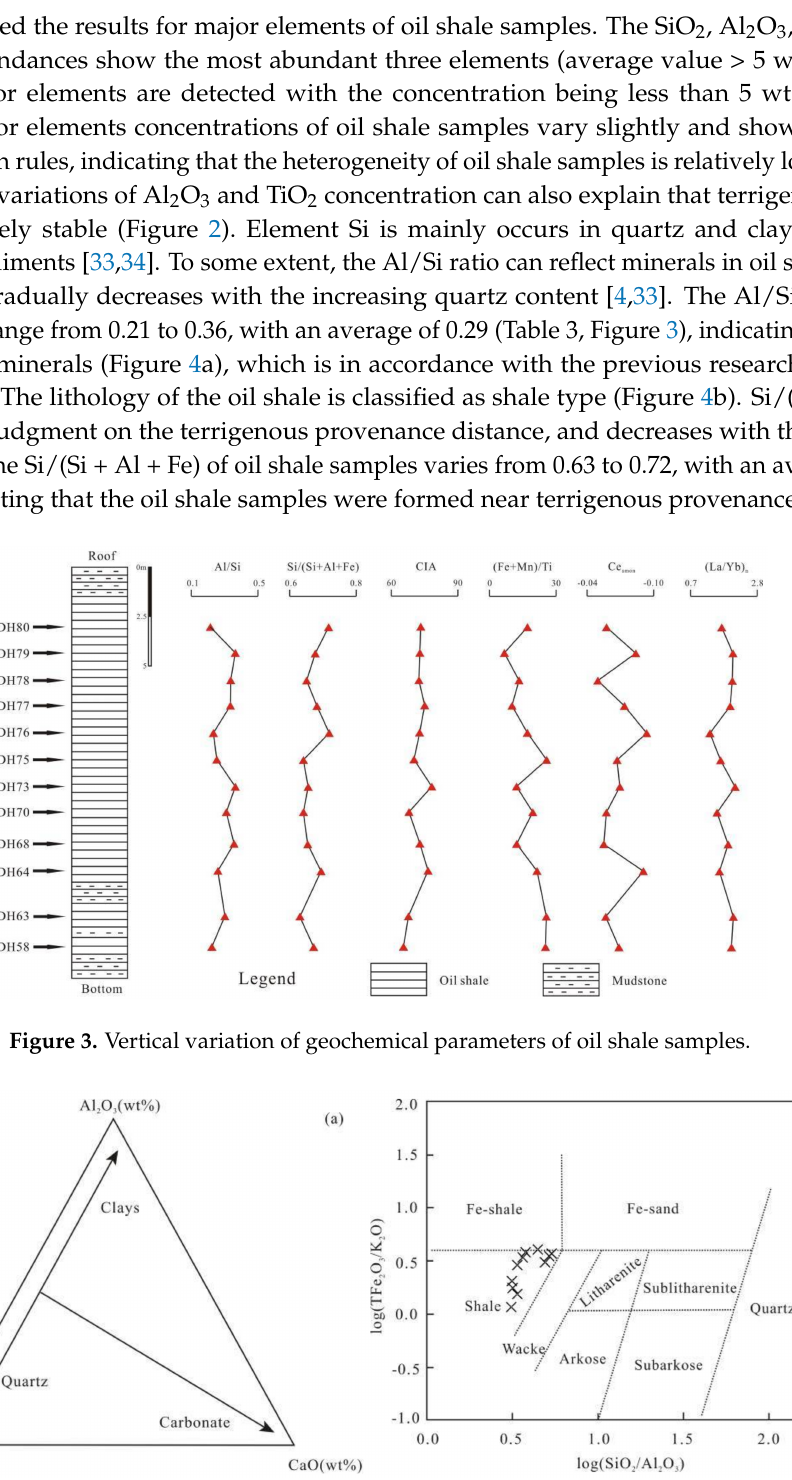
Figure 4. ( a ) Ternary diagram showing relative proportions of major elements (the base map is from He et al. [36]); ( b ) lithology classification of oil shale samples (the base map is from Herron.